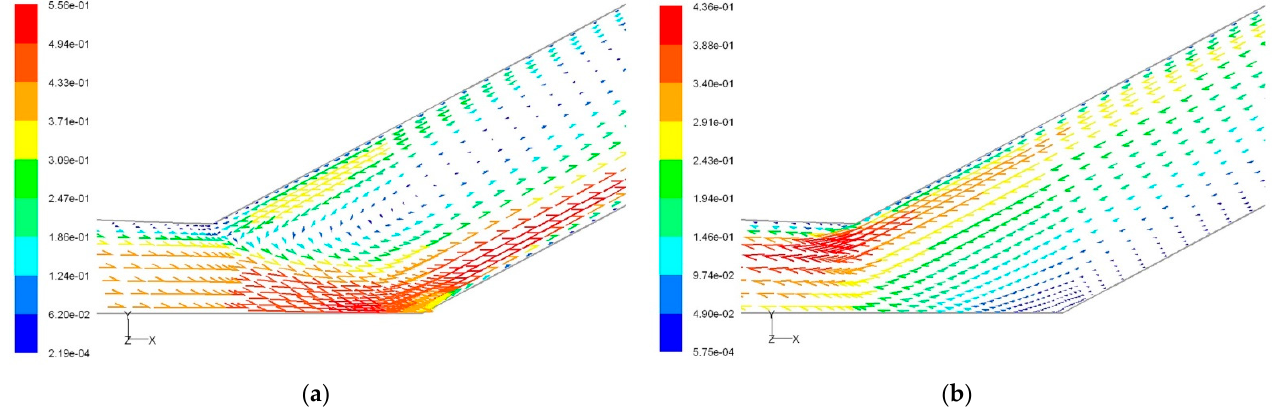
Figure 9. Vectors of the velocity magnitude (m/s) in the median x-y plane in the vicinity of the iliac bifurcation: for the deceleration phase, t 3 ( a ), and for the reverse phase, t 4 ( b ).